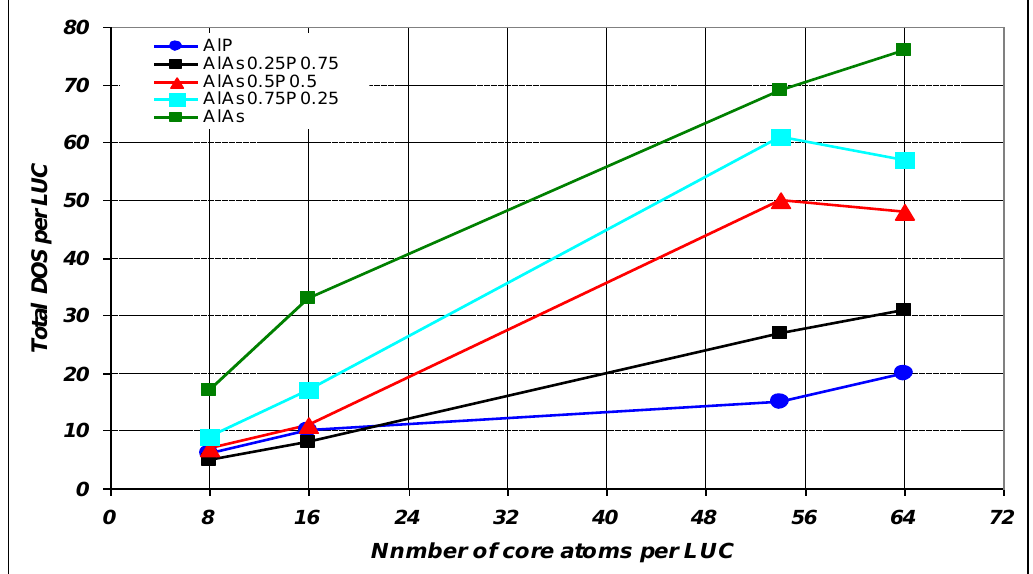
Fig .9: Density of state of AlAs Fig.